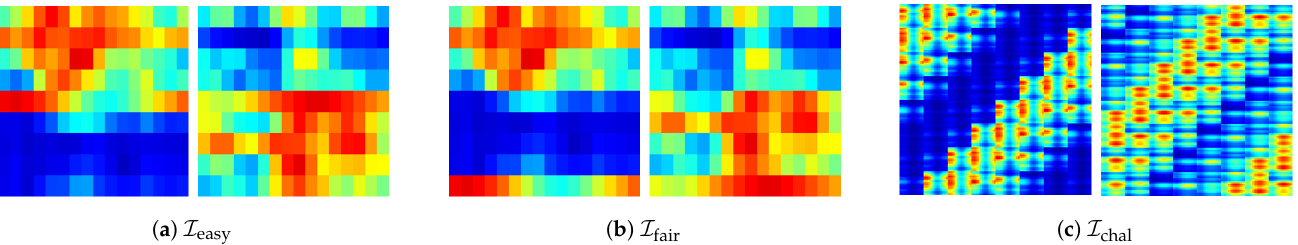
Figure 3. The examples of I easy , I fair , and I chal : For all ( a – c ), a pair of figures represents dumbbell curl ( left ) versus dumbbell kickback ( right